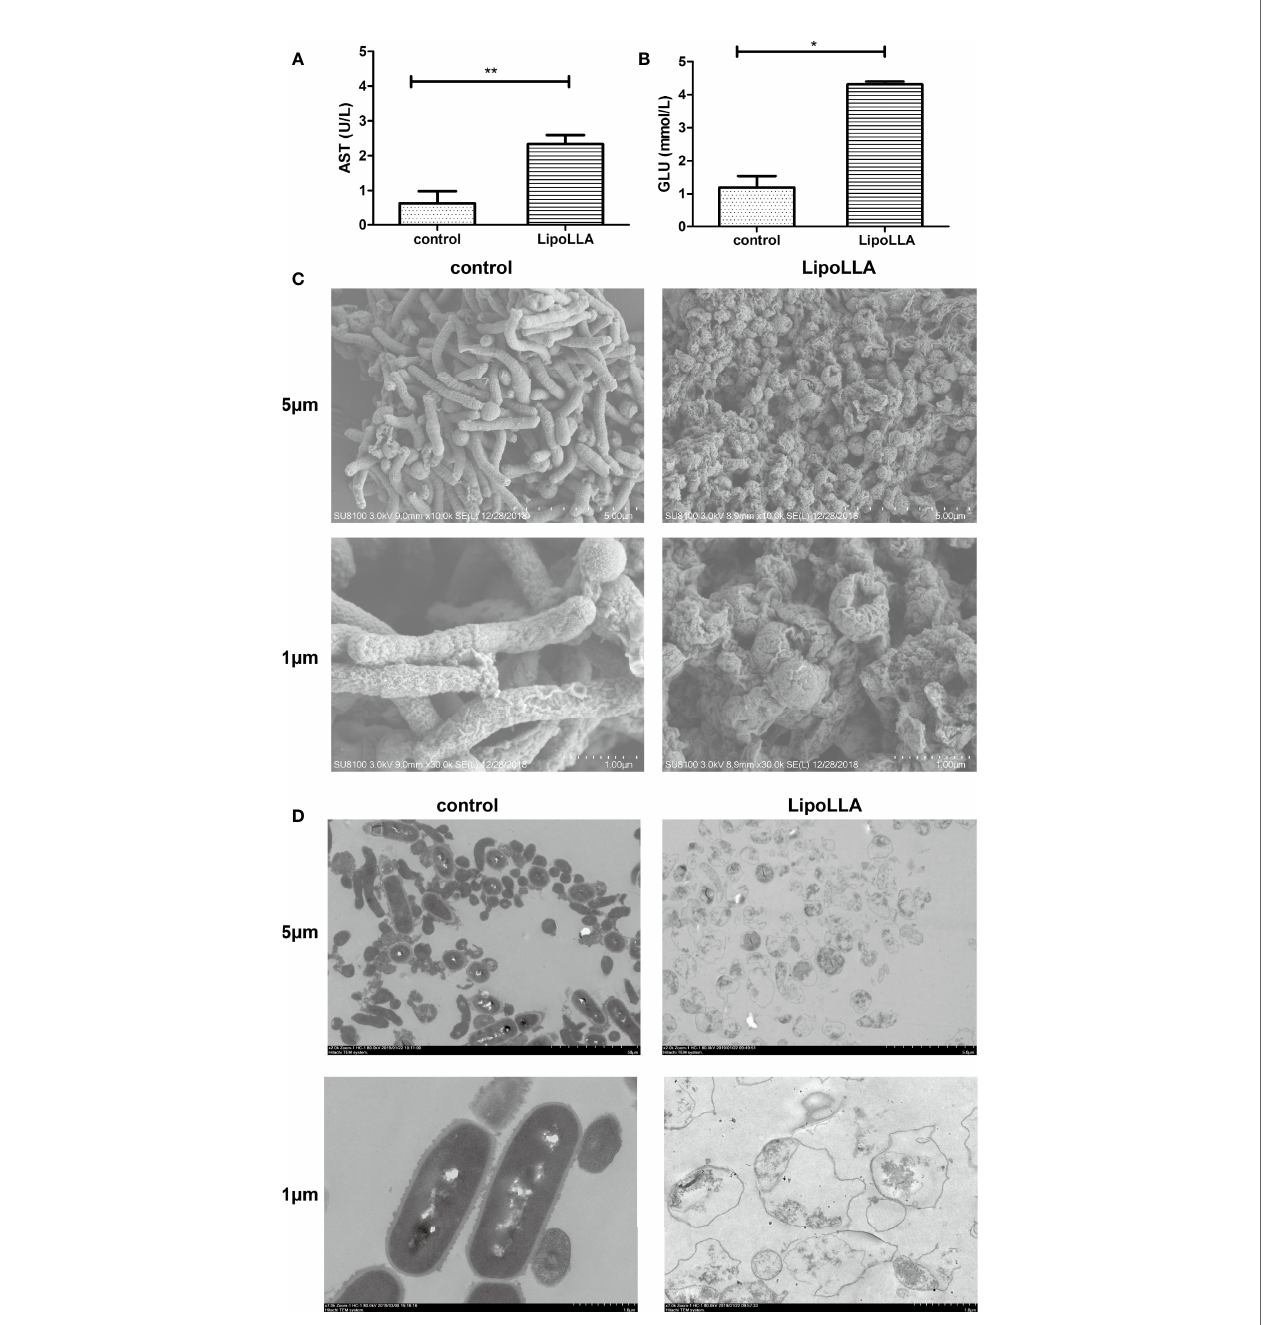
FIGURE 4 | Effect of LipoLLA on the outer membrane barrier and ultrastructure of H. pylori. Levels of aspartate aminotransferase (A) and glucose (B) in SS1 supernatant after LipoLLA treatment, *P < 0.05; **P < 0.01. Scanning electron microscopy images of SS1 after LipoLLA treatment (C) . Transmission electron microscopy images of SS1 after LipoLLA treatment (D) . Scale bars represent 5 um and 1 um